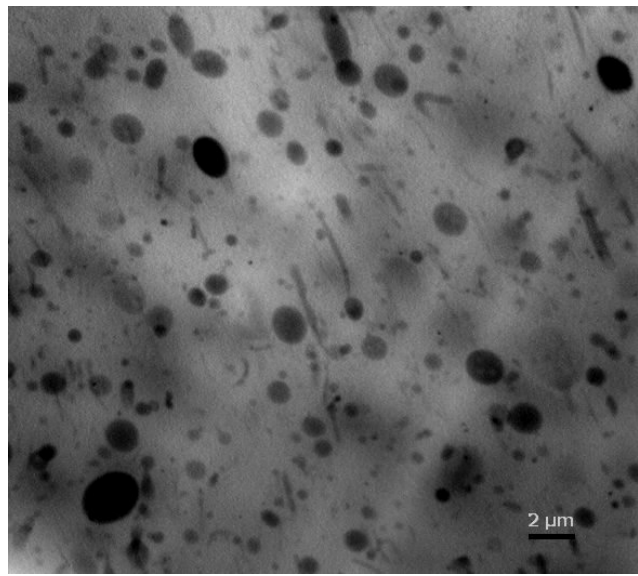
Figure 3. Transmission electron microscopy (TEM) analysis obtained for the product obtained by run 2 at t = 30